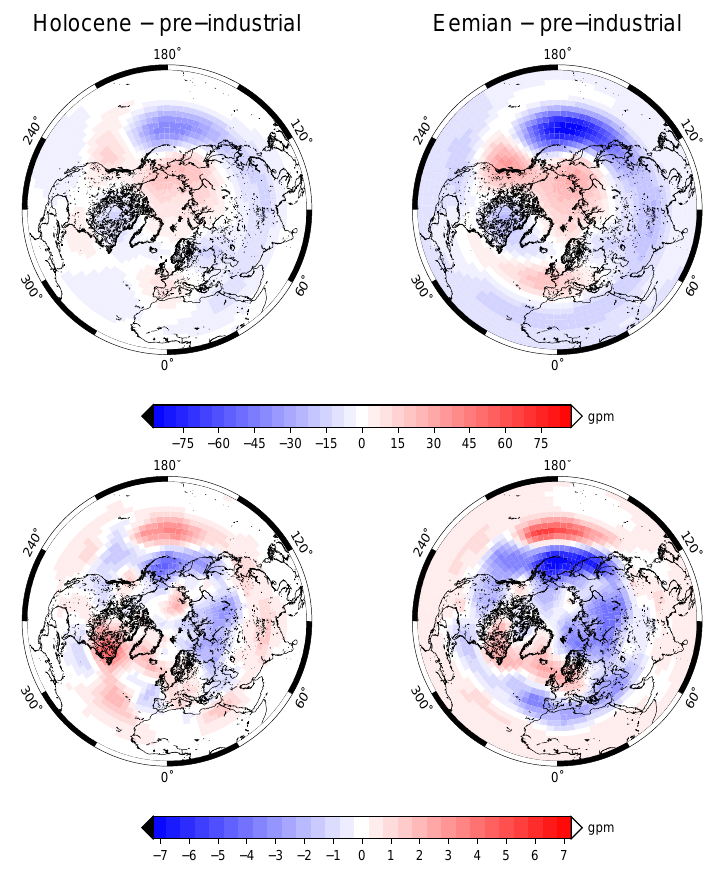
Fig. 4. Northern Hemisphere differences in mean winter geopotential height in gpm (upper row) and winter storm tracks, defined as synoptic- scale geopotential height anomalies at 500hPa in gpm (lower